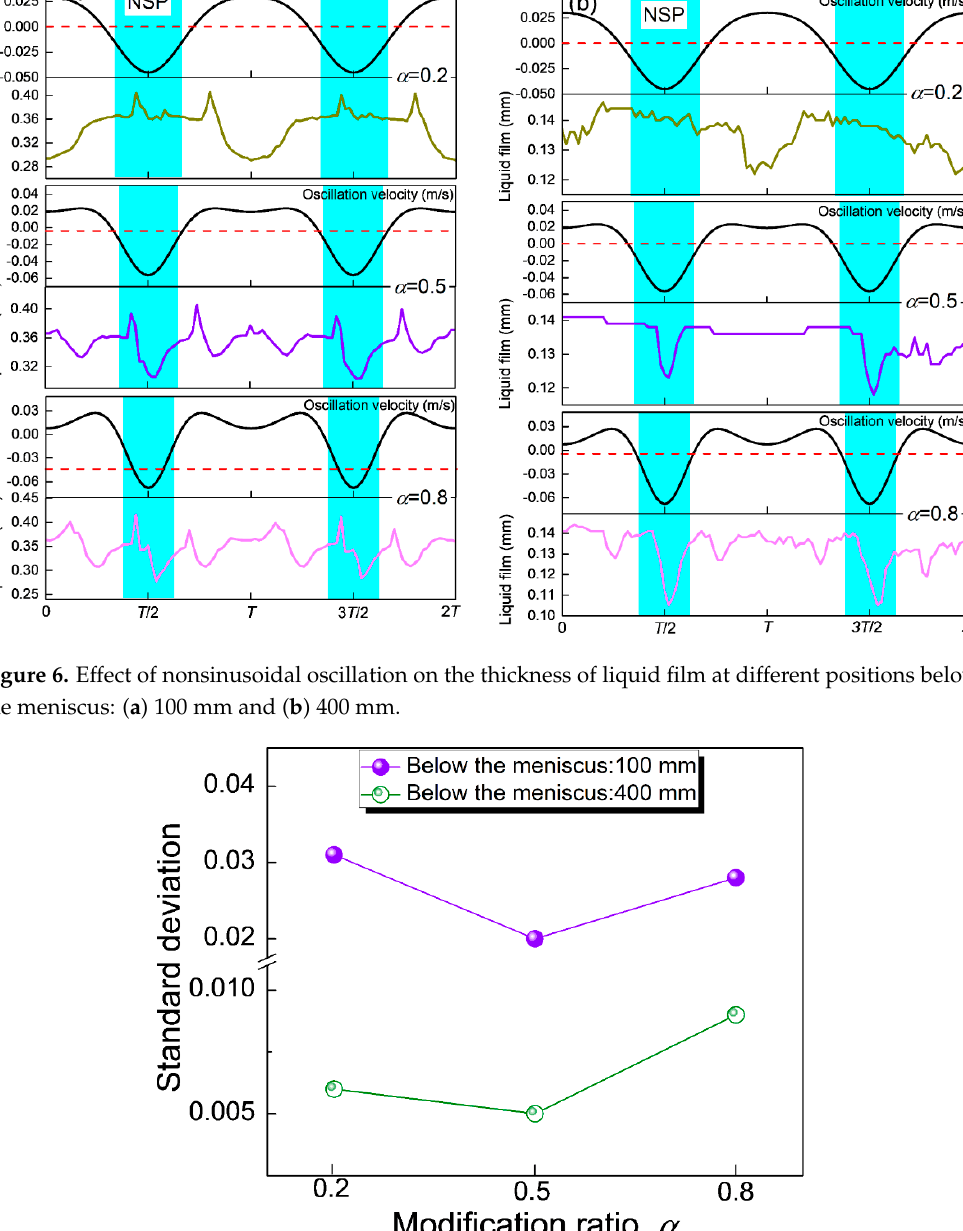
Figure 7. Standard deviation of liquid film thickness with different modification ratios.